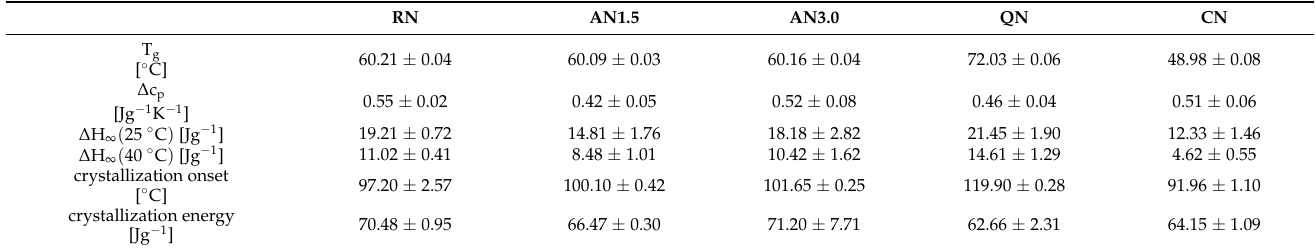
Table A1. Calorimetric data of the 2gl_0.0PS_Suc [ ◦ C]. n = 2, values represent the mean value and the corresponding standard deviation.